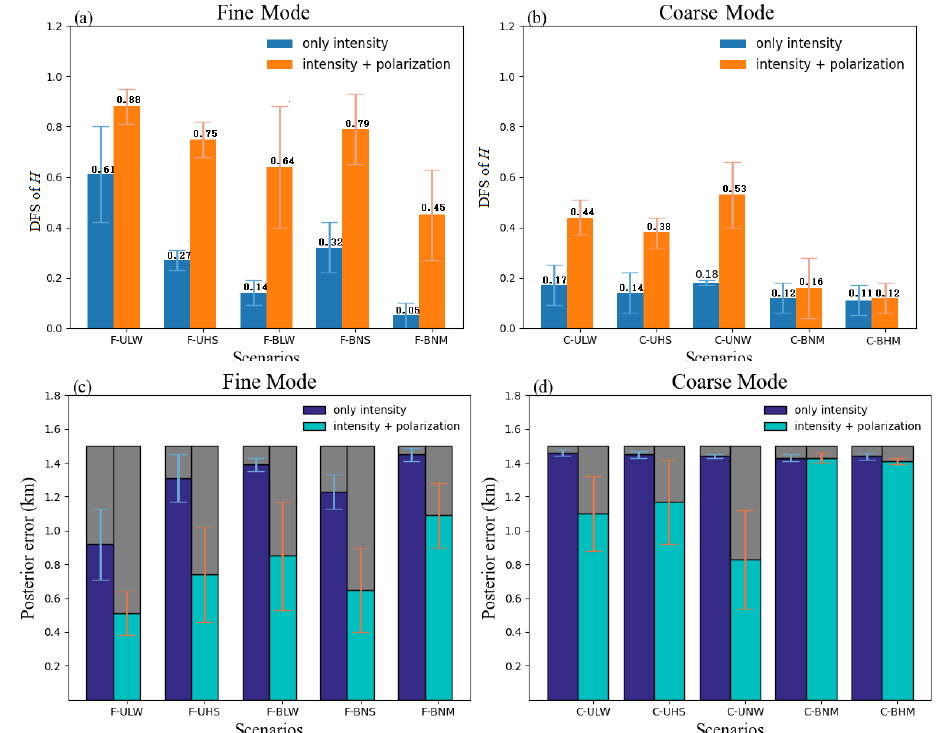
Figure 5. The DFS and posterior error of H for different aerosol models with AOD = 0.6 for two aerosol types over vegetation surfaces. The error bar are the mean value and standard deviation of different geometries and the aerosol profile H is defined as 2 km. ( a , c ) represents fine mode aerosol types and ( b , d ) represents coarse mode aerosol types.